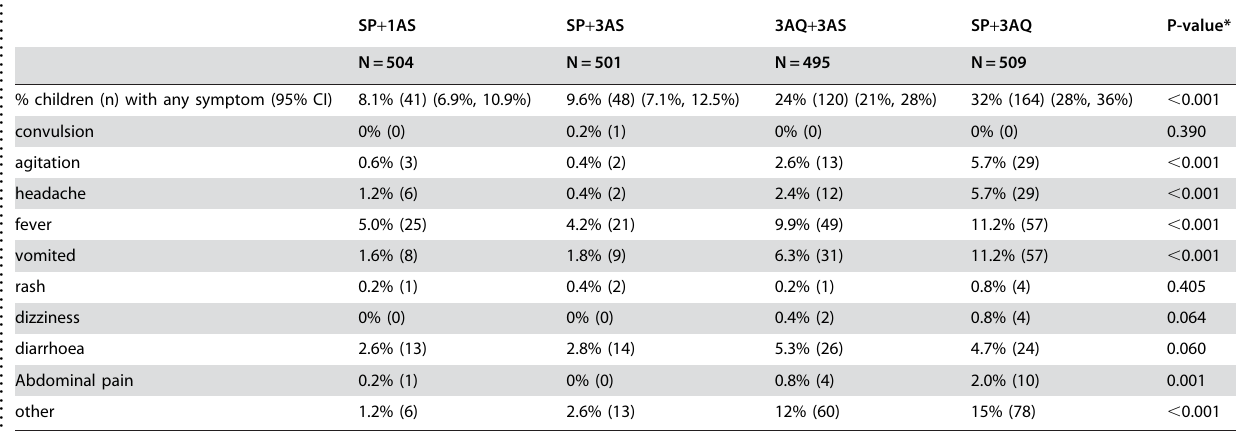
Table 4. Adverse events recorded during the week after each treatment by treatment group. .. ... .... ... ... .... ... ... .... ... ... .... ... ... .... ... ... .... ... ... .... ... ... .... ... ... .... ... ... .... ... ... .... ... ... .... ... ... .... ... ... .... ... ... . SP + 1AS SP + 3AS